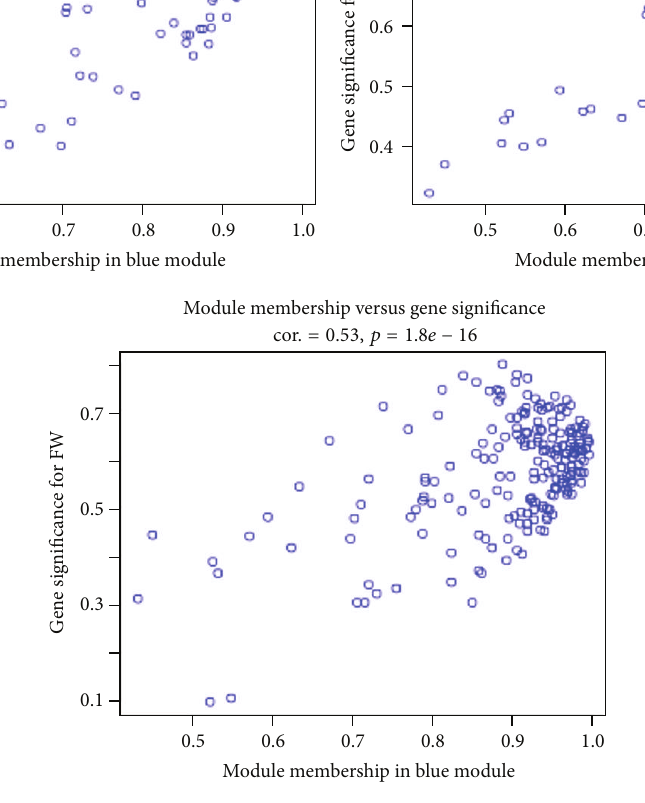
Figure 6: Intramodular analysis of gene significance (GS) and module membership (MM) of the genes in the blue module. Data for trait DW was not included, which is nearly identical to that of